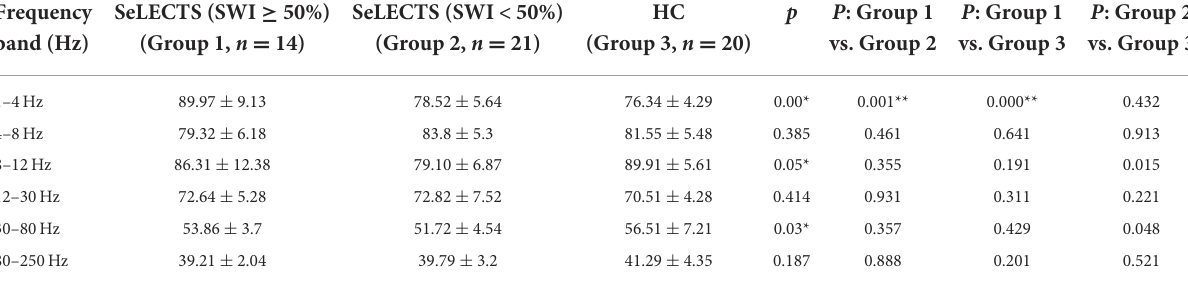
TABLE 4 Comparison of neuromagnetic source strength between the SeLECTS (SWI ≥ 50%), SeLECTS (SWI < 50%), and HC